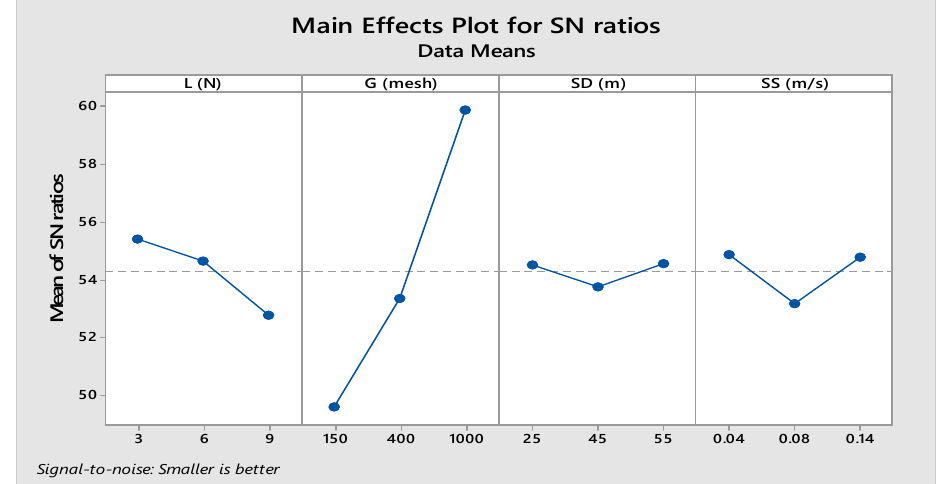
Figure 11. Main effect plot for SNRs of mean M L .